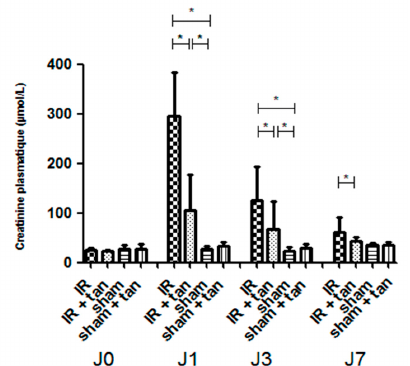
Figure 3. Tannic acid injection improves renal function recovery after warm kidney ischemia– reperfusion. Rats were subjected to sham or bilateral renal ischemia for 60 min by renal pedicle clamping with or without prior injection of tannic acid. Renal function was evaluated by creatinine plasma levels concentrations. n = 8, values are mean ± SD, * p < 0,05.